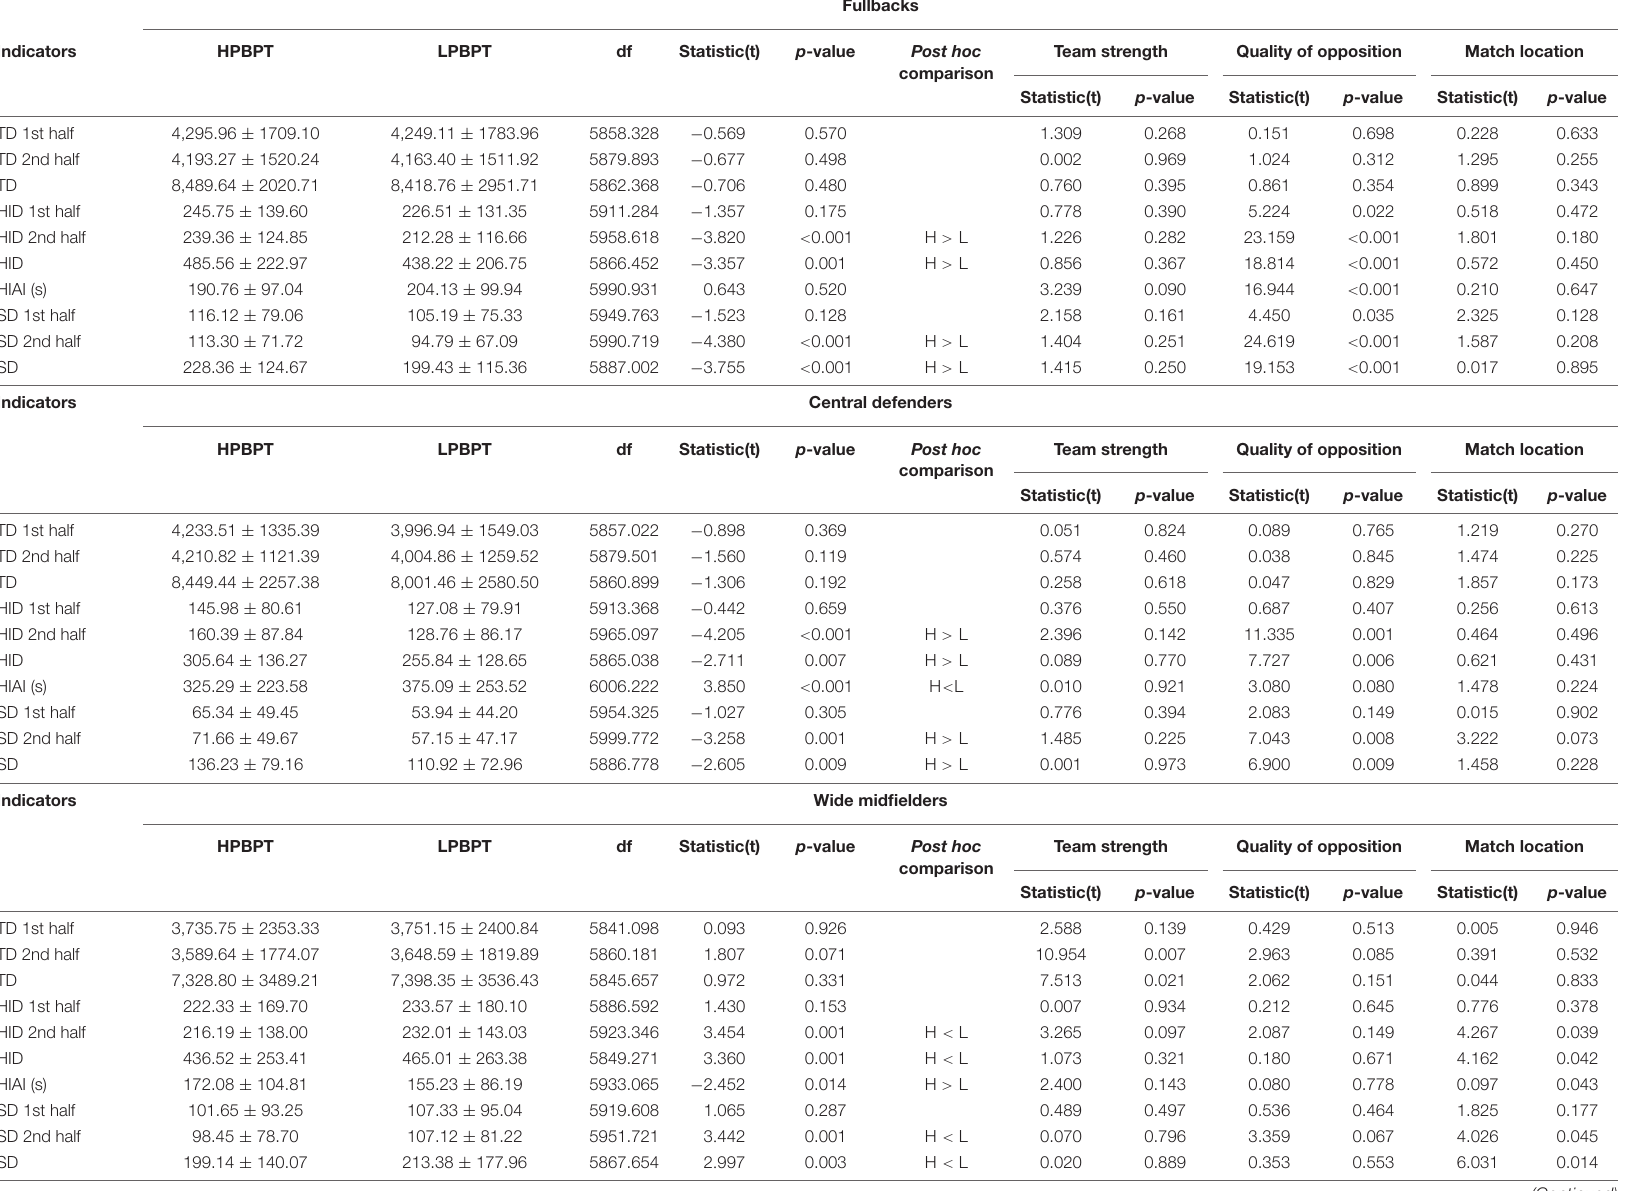
TABLE 3 | Running performance in terms of playing position between HPBPT and